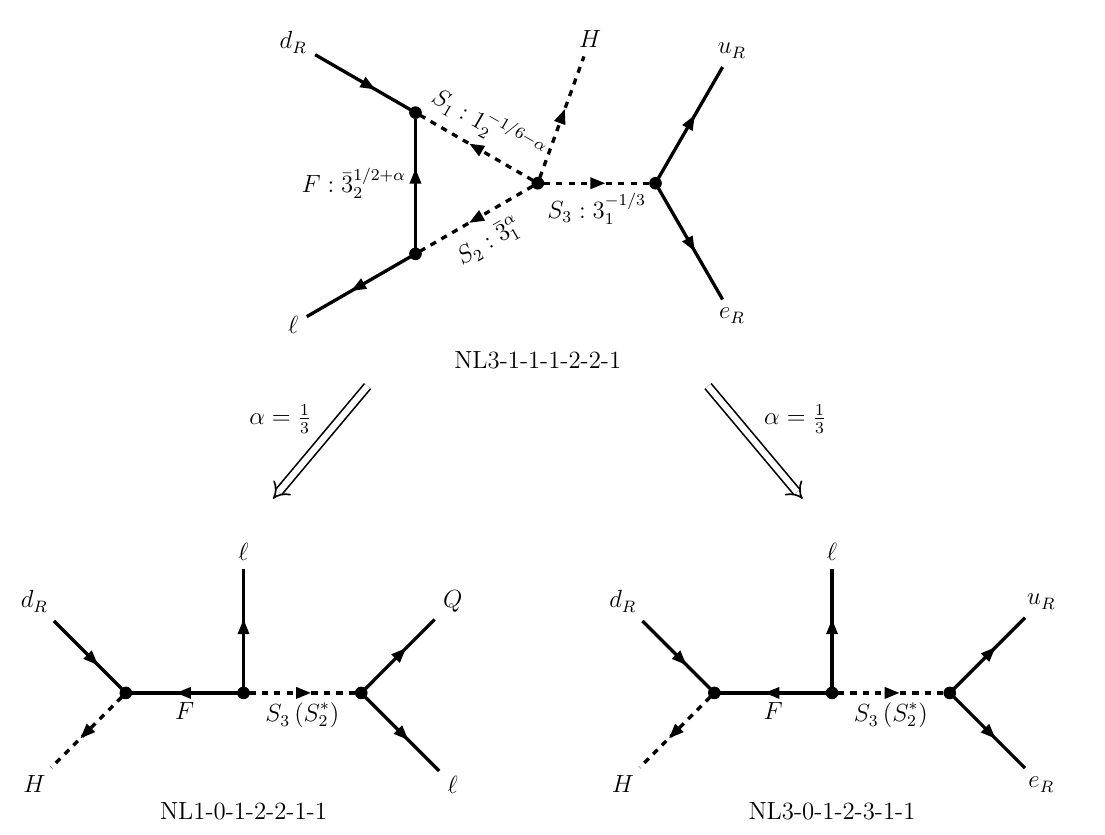
Figure 11 . One example of the non-genuine model NL3-1-1-1-2-2-1, and the messenger fields F , S and S can lead to the tree-level contributions NL1-0-1-2-2-1-1 and NL3-0-1-2-3-1-1 in the 2 3 case of α = 1 . Notice that the mediators F , S 3 NL1-0-1-2-2-1-1, NL3-0-1-2-3-1-1, NL3-0-1-1-3-1-1 when the hypercharge parameter α = ± 1 .